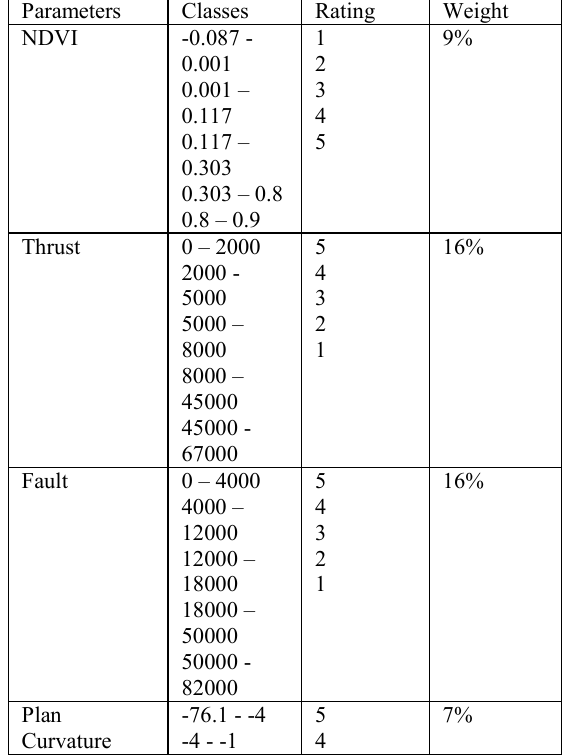
Table 9 Classes of the parameters and according weights for landslide vulnerability